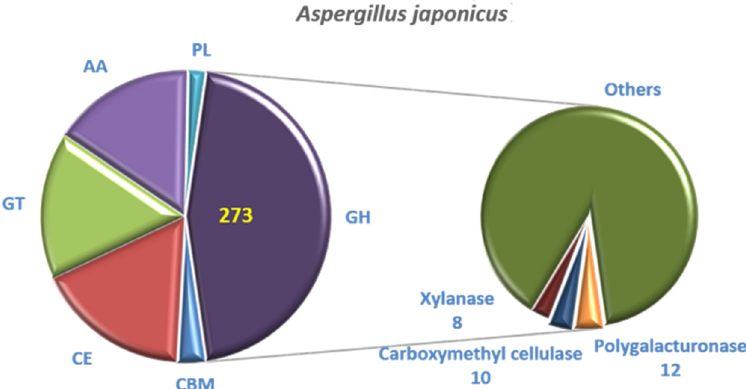
Figure 10. CAZyme annotation result of A. japonicas PJ01.